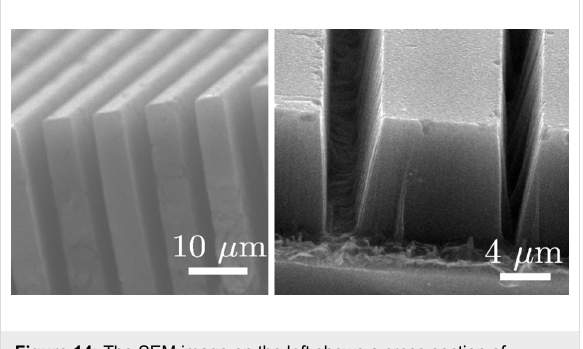
Figure 14: The SEM image on the left shows a cross section of vertical structures, obtained by MaCE etching: Patterned Au struc- tures have been used as a catalyst. The etching solution was HF:H 2 O 2 :H 2 O 3:1:10 in volume. The cross section of the SEM image on the right shows trenches in a silicon substrate obtained by